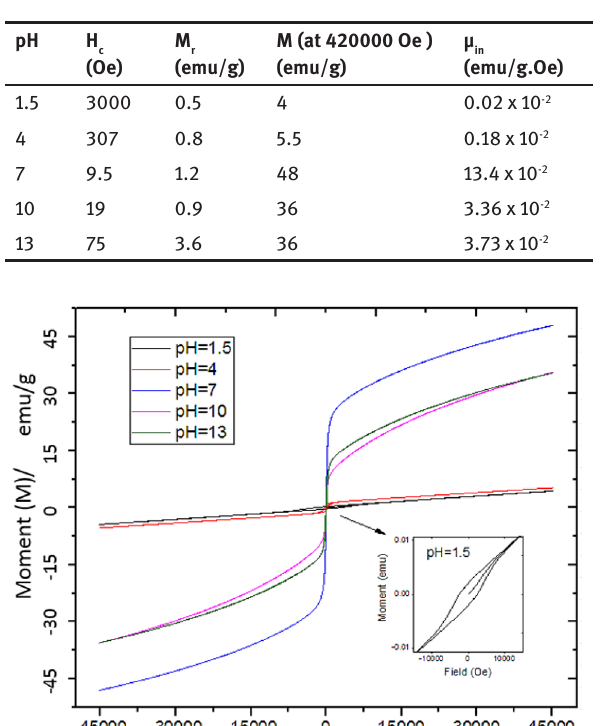
Table 3: Magnetic parameters for samples prepared at pH=1.5, 4, 7, 10, 13.